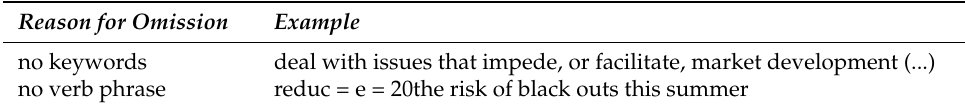
Table 3. Examples of reasons for false